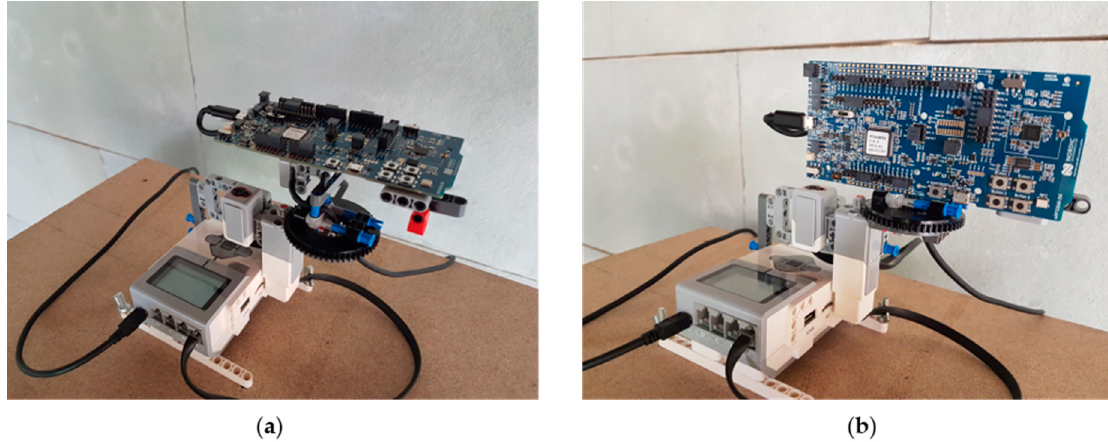
Figure 1. Views of the nRF52840 DK receiver coupled to the orienting device (OD): ( a ) Horizontally and ( b ) vertically.